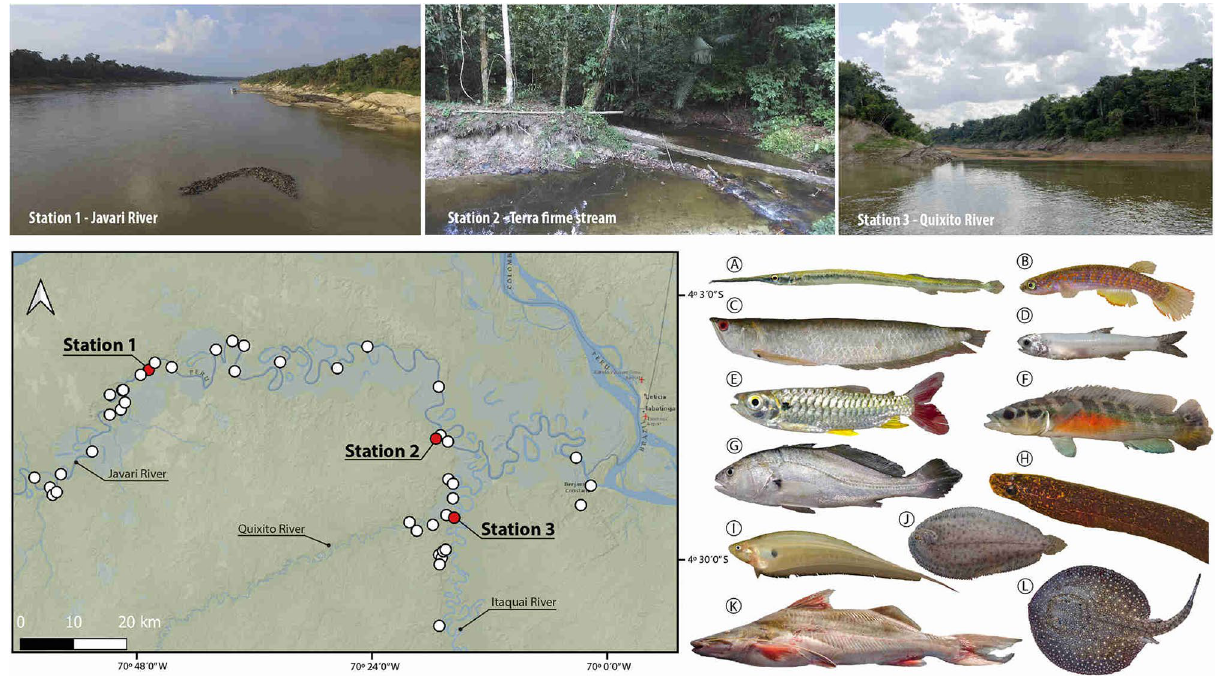
Figure 1. Map of Javari River basin showing 46 sampling stations (white and red dots). Red dots represent stations in two distinct ecosystems (River: stations 1—Javari, 3—Quixito; Stream: station 2— Terra firme stream) sampled by capture and molecular based methodologies. In the map one dot can represent more than one station. Illustration of 12 orders detected by capture-based sampling (CBS) and molecular based